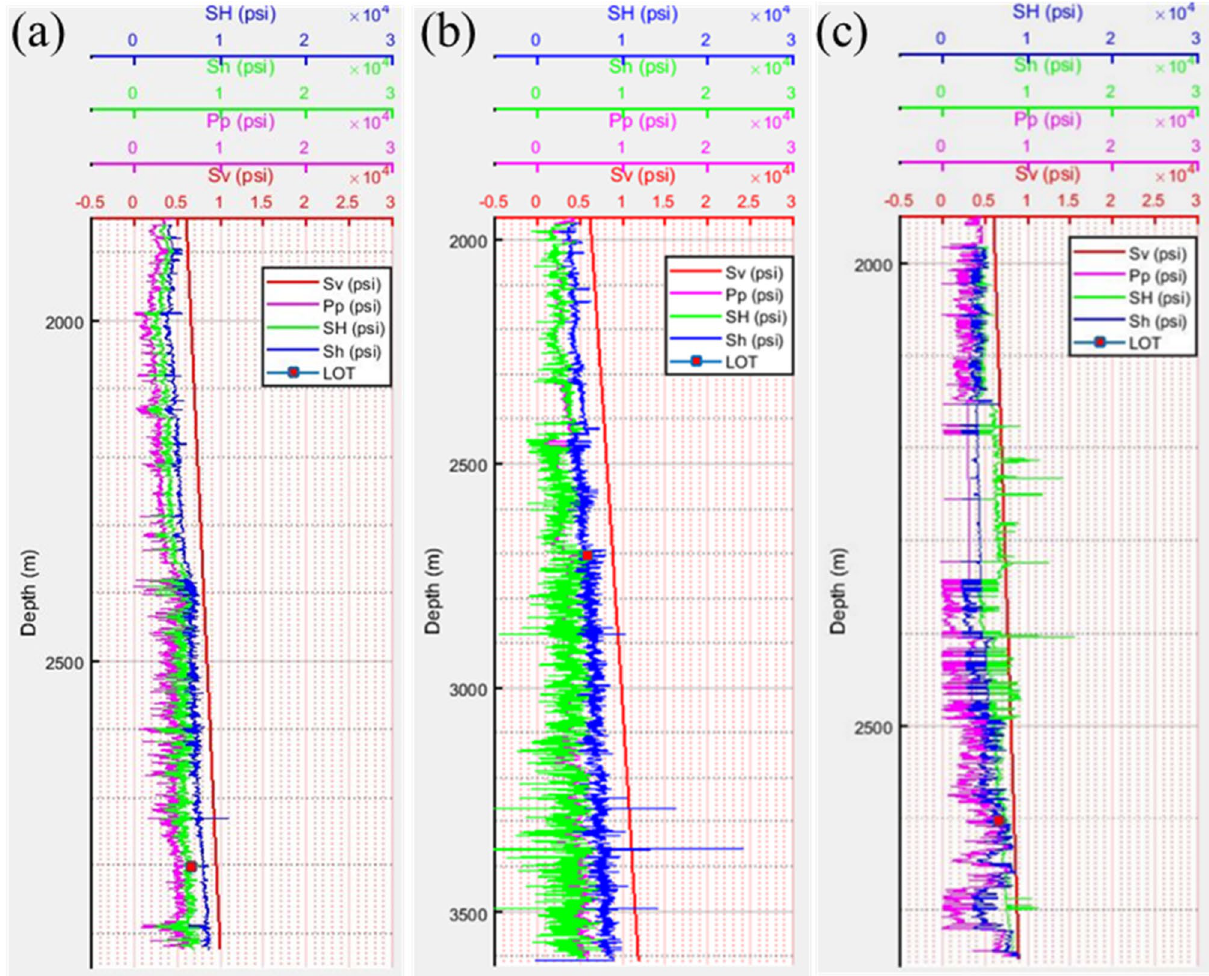
Figure 13. Estimation of in-situ stress and pore pressure for well ( a ) MD-01, ( b ) MD-27, and ( c )